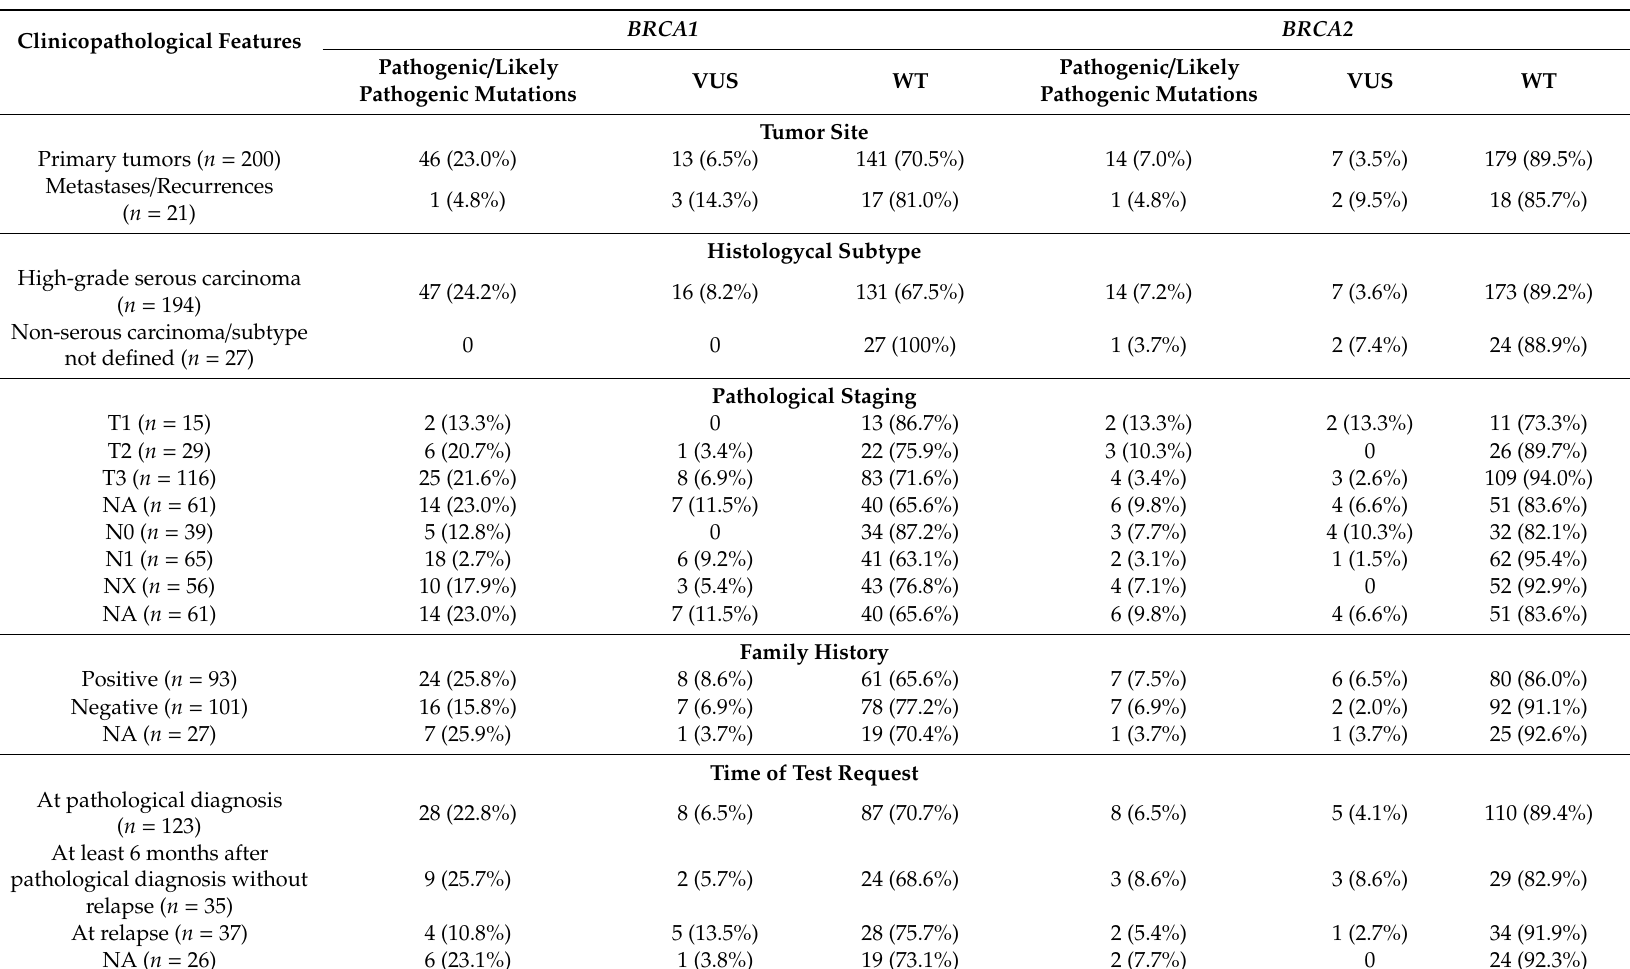
Table 1. Tumor BRCA1 and BRCA2 alterations distribution according to the clinicopathological parameters of the 221 cases successfully analyzed. BRCA1 BRCA2 Clinicopathological Features Pathogenic /